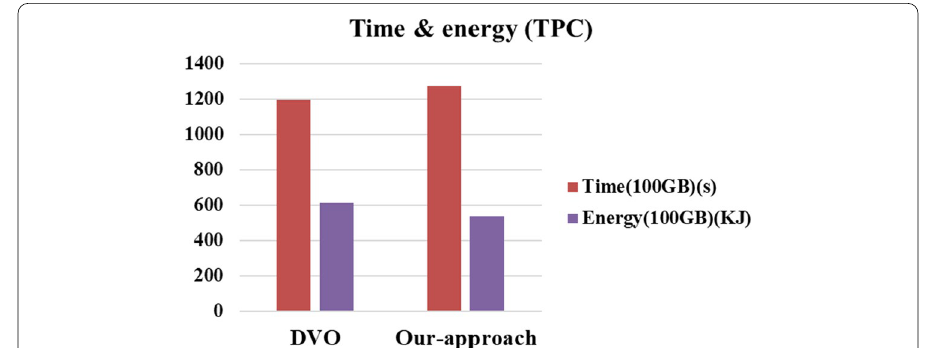
Fig. 9 Processing time and energy of TPC Datasets